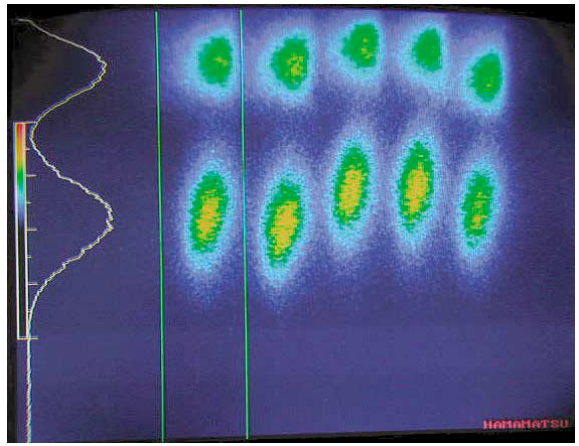
FIG. 32. (Color) A typical streak camera image of unstable col- liding beams in CESR. The bunches (same arrangements as Fig. 31) in a train do not line up